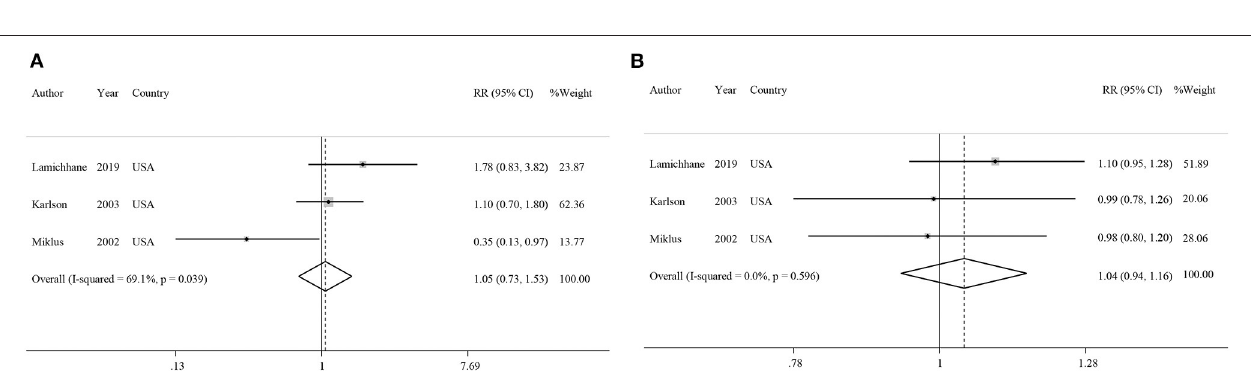
Association Between Tea Consumption and Risk of RA Three studies had examined the association between tea intake and risk of RA (39–41). Pooled effect sizes for the highest vs.